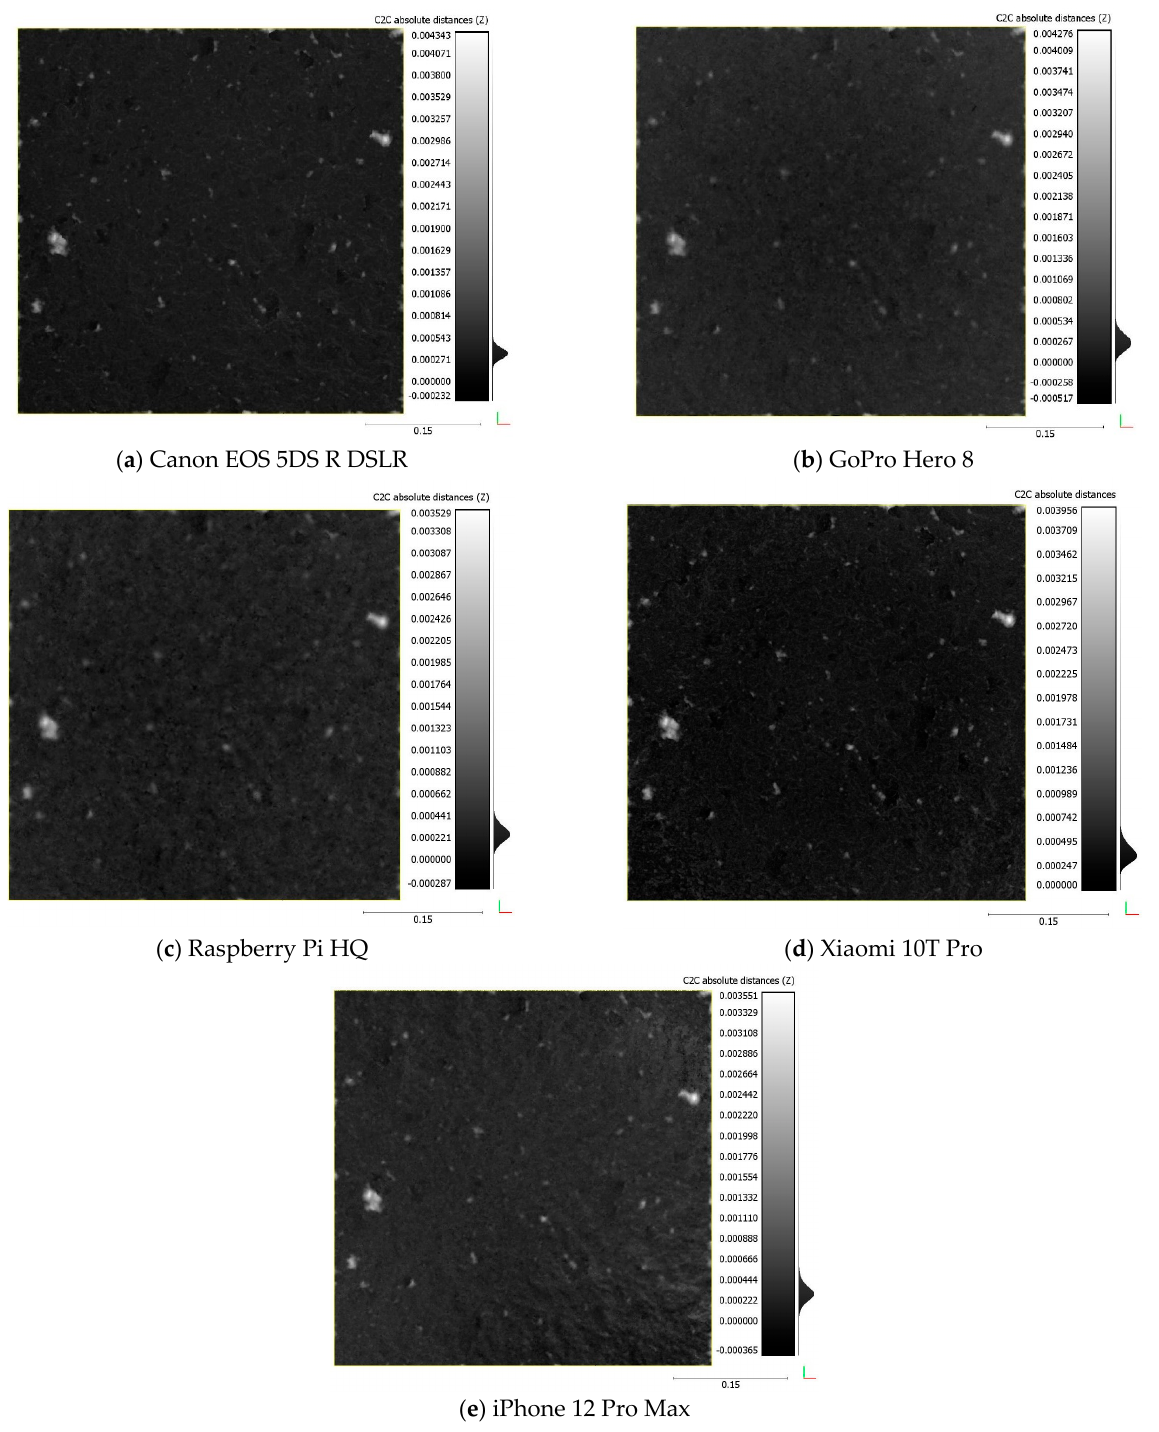
Figure 11. Physical apertures determined by cloud-to-cloud distance of bottom and top surfaces of each camera with a rasterization grid interval of 0.5 mm.